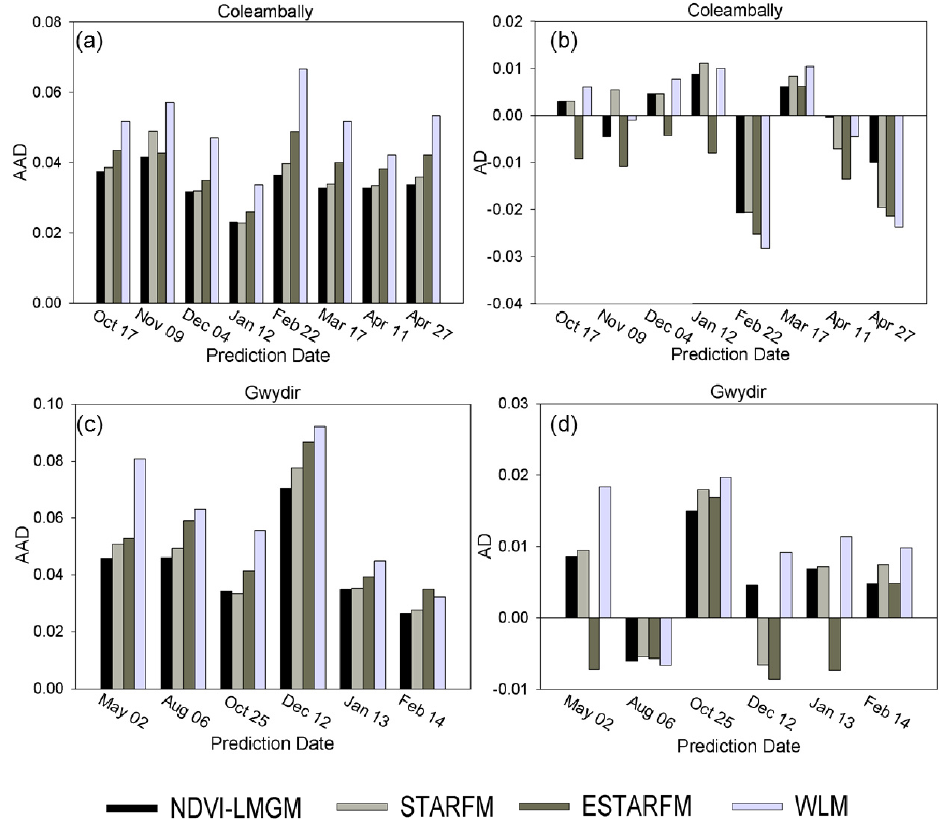
Figure 10. The accuracy assessment of predicted NDVI via the four methods at the Coleambally and Gwydir sites for each prediction date: ( a ) AAD values in Coleambally, ( b ) AD values in Coleambally, ( c ) AAD values in Gwydir, and ( d ) AD values in